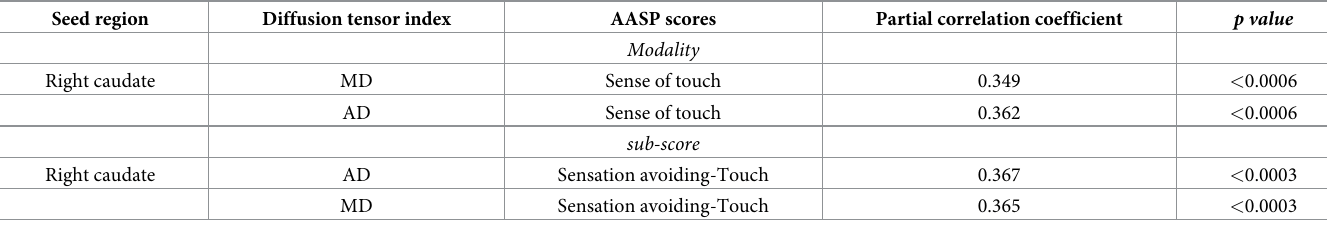
Table 3. Association between diffusion parameters and Adolescent/Adult Sensory Profile (AASP) scores or AASP sub-scores. Seed region